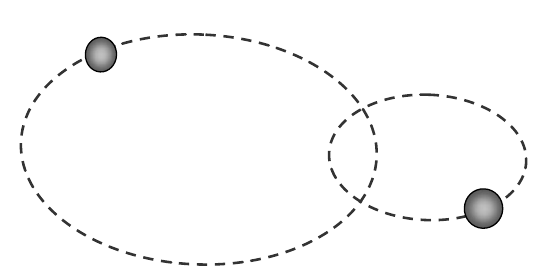
FIG. 19. Diagram of two stars in deep space orbiting around each other.